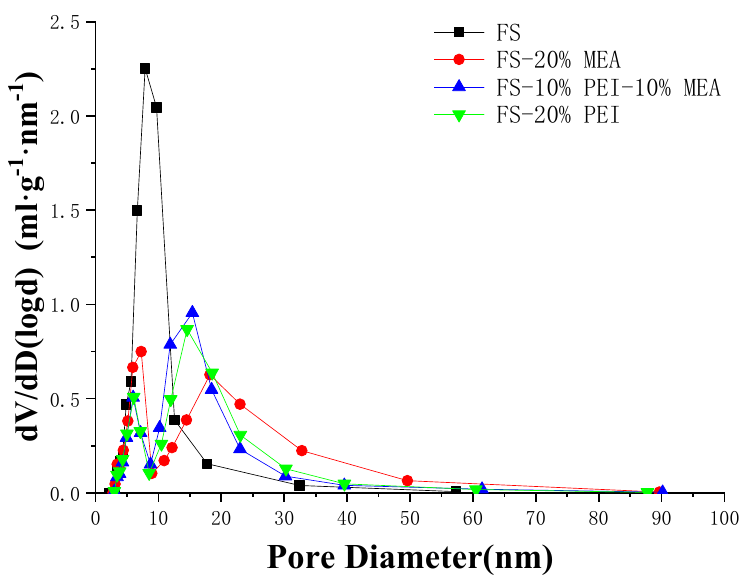
Figure 4. Pore size distribution.